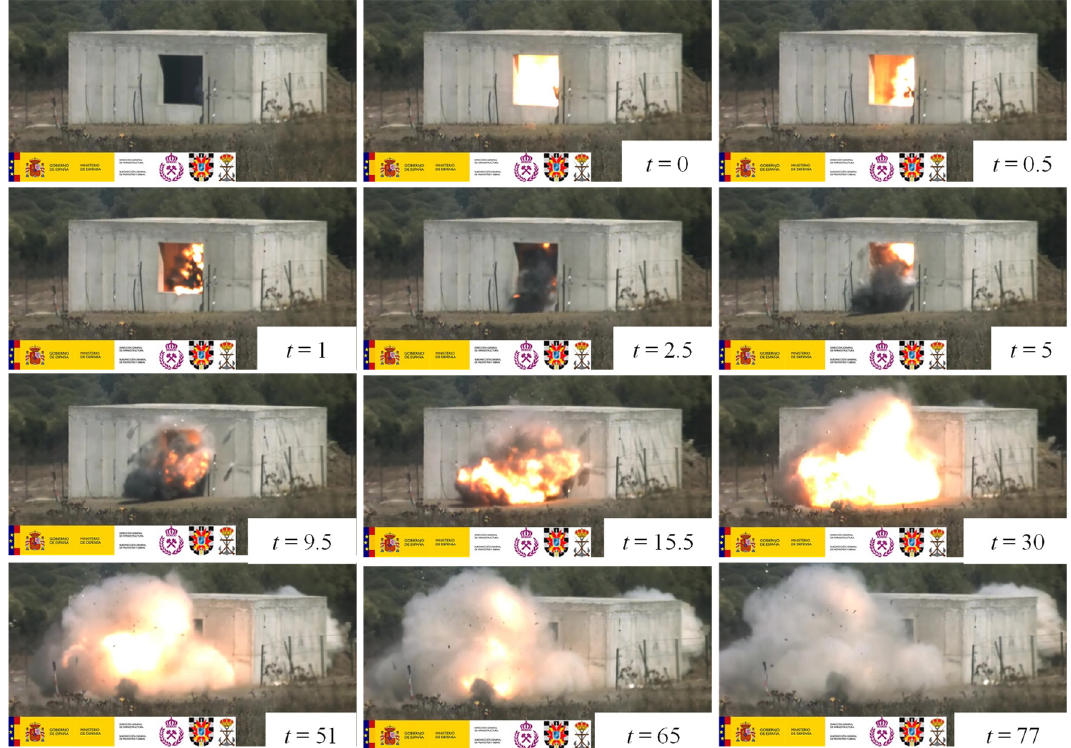
Figure 6. Sequence of images obtained with HSC in trial T6: AN/AL. Time in milliseconds; the reference time is the first frame of the video where the detonation is observed.